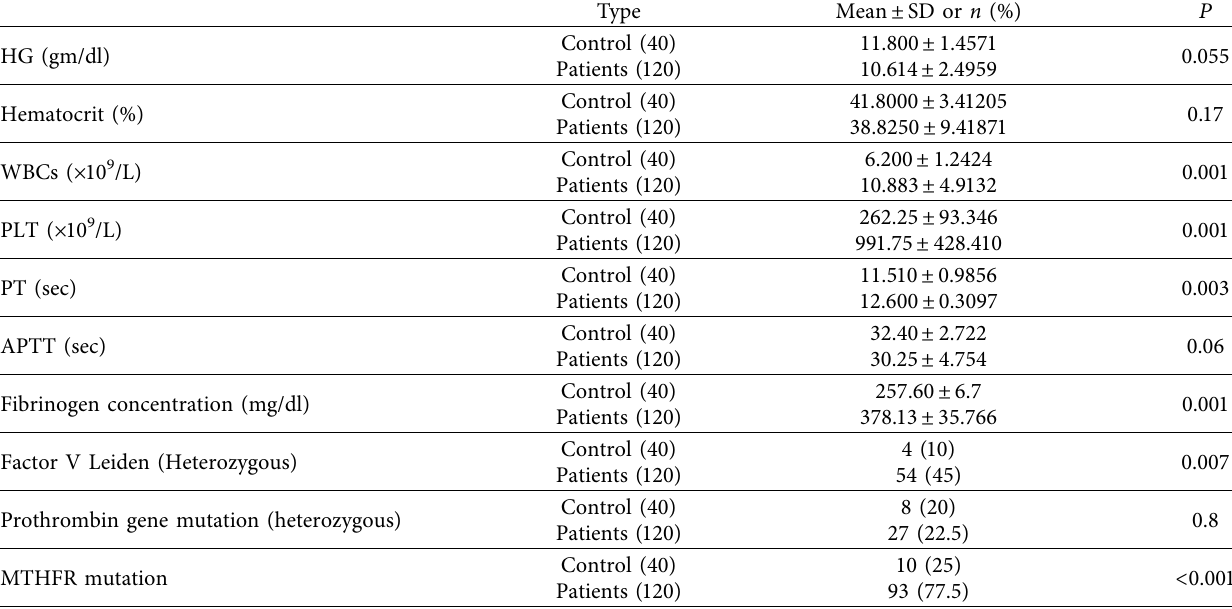
Table 2: Statistical analysis of patients’ haemogram and coagulation profile tests in unthrombosed compared to those developed